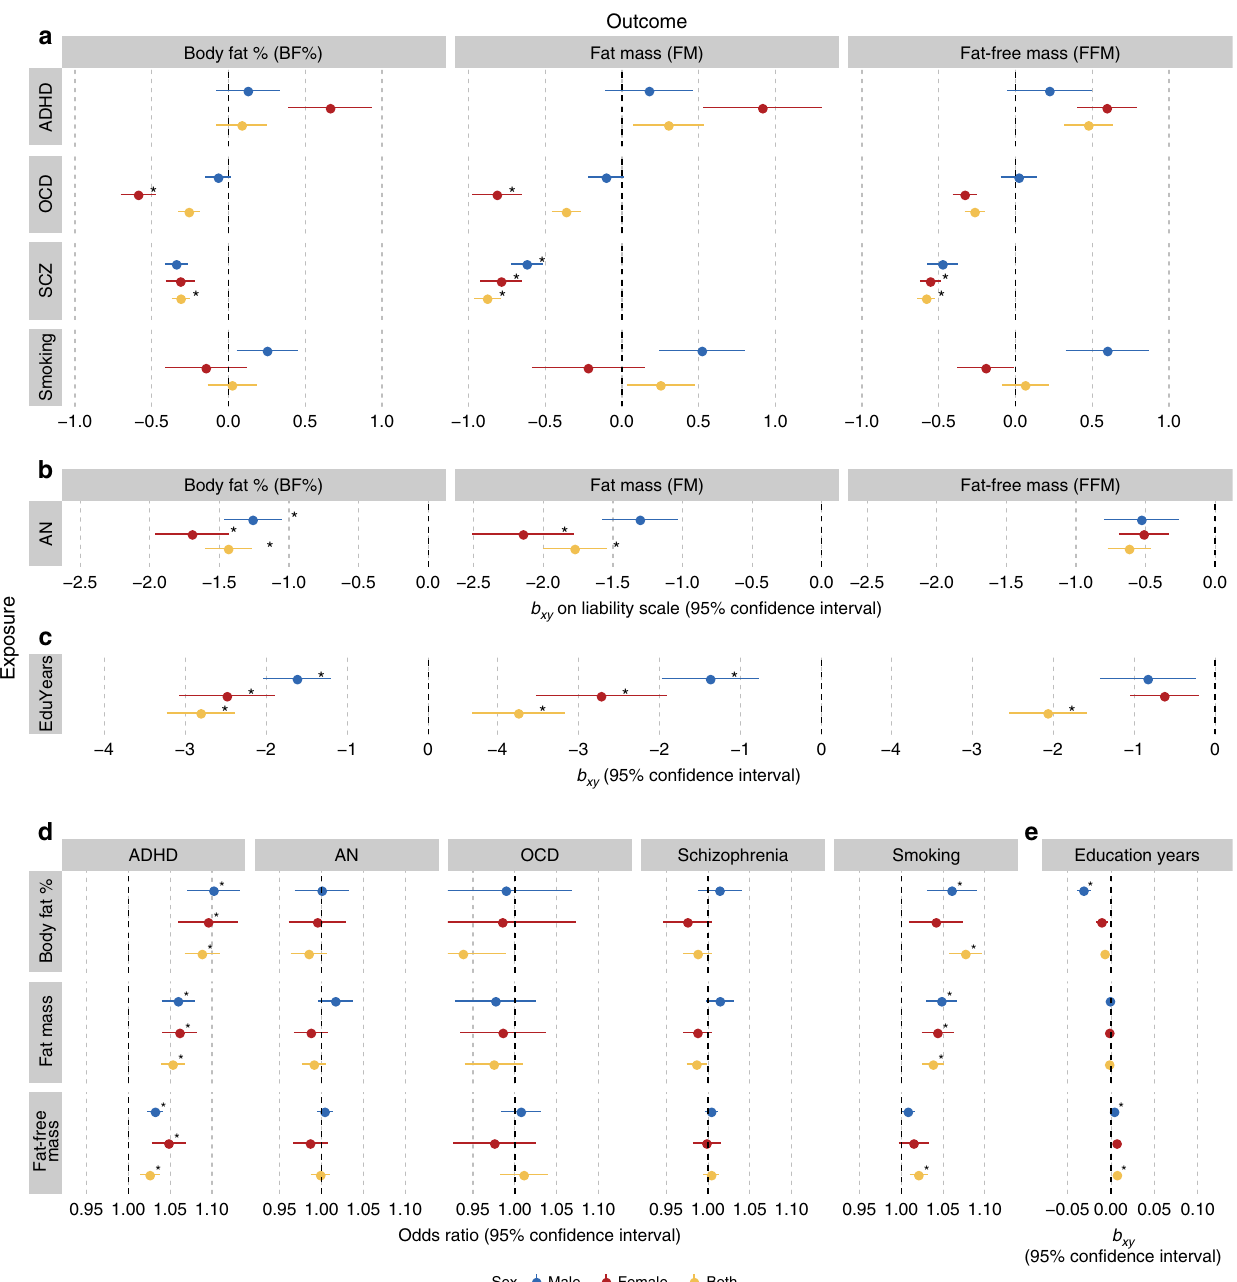
Fig. 2 Causal associations between body composition and psychiatric traits. Results are shown from generalized summary data-based Mendelian randomization (GSMR) analyses. Colours represent the sex of the body composition trait: red for female effects, blue for male effects and yellow for sex-combined effects. Error bars represent 95% con fi dence intervals (95% CIs) and asterisks indicate statistically signi fi cant estimates with p values less than α = 2.6 × 10 − 4 . a Putative causal associations of exposures (rows) psychiatric disorders ( n = up to 77,096) and behavioural traits ( n = up to 217,568) with outcomes (columns) body composition traits ( n = up to 155,961). Dots represent the effect sizes (as measured by β , b xy ) on the liability scale of the disorders or traits. b , c Mendelian randomization results for the exposures anorexia nervosa and education years on the outcomes the body composition traits. These are plotted differently due to the size of the effects. All estimates are presented together in Supplementary Fig. 1 on the same scale. d Putative causal associations of exposures (rows) body composition traits ( n = up to 155,961) with outcomes (columns) psychiatric disorders ( n = up to 77,096) and behavioural traits ( n = up to 217,568). Dots represent the effect sizes (as measured by odds ratios, ORs) of risk factors on disorders or traits. e The Mendelian randomization results for body composition traits as exposures on the outcome years of education. Dots represent the effect sizes (as measured by β , b xy ) on the scale of the risk factors. Abbreviations: ADHD = attention-de fi cit/ hyperactivity disorder, AN = anorexia nervosa, BF% = body fat percentage, EduYears = education years, FFM = fat-free mass, FM = fat mass, OCD = obsessive compulsive disorder, SCZ =